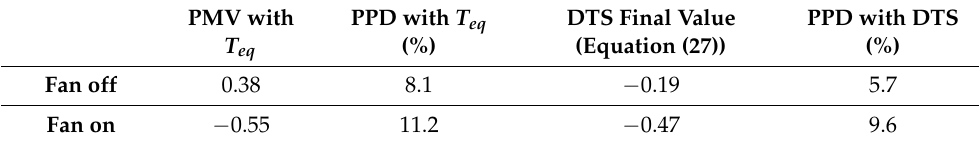
Table 6. Global PMV, PPD, and DTS values for the environmental chamber.